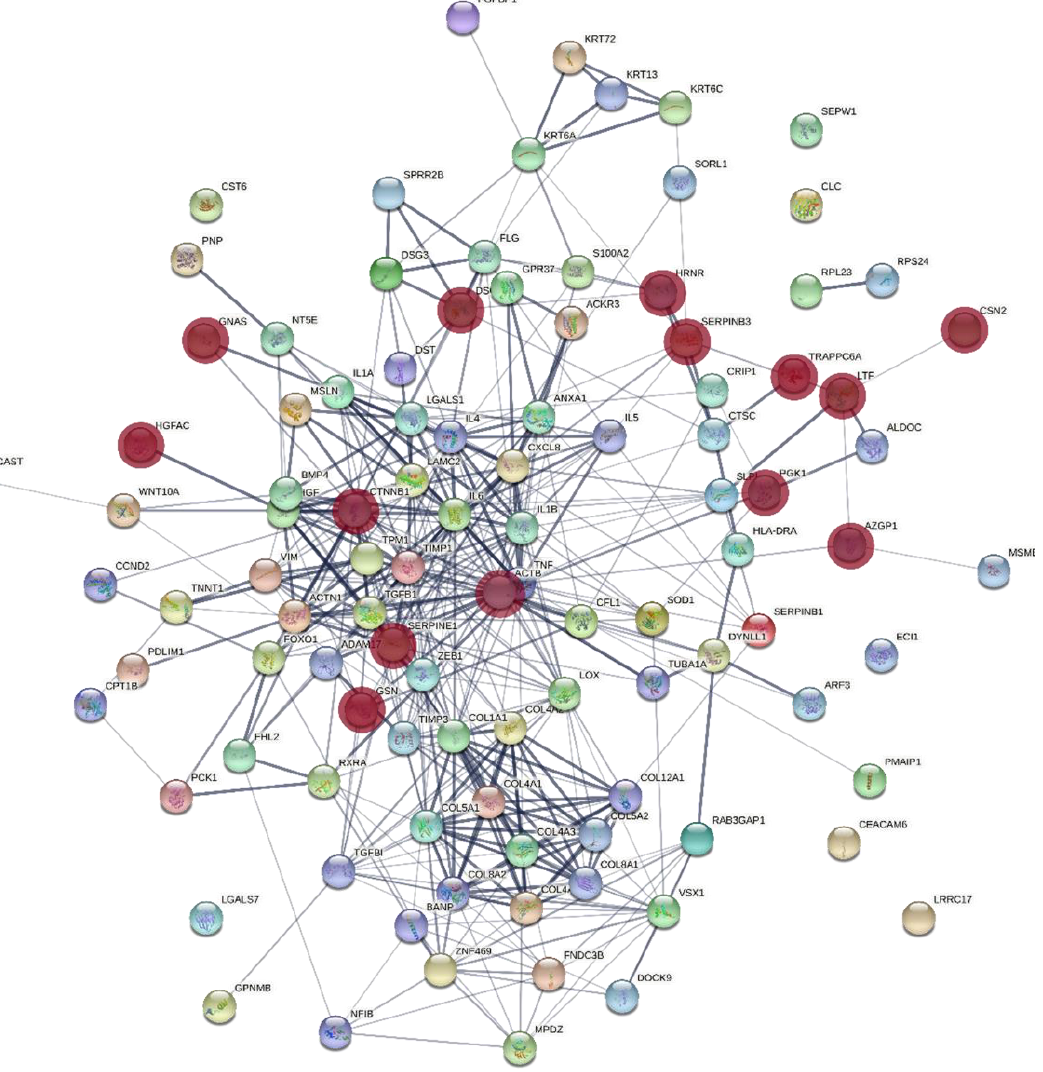
Figure 4. Functional association network of genes associated with central corneal thickness and KC. The STRING program was used to model the functional association of proteins whose expression is altered in exosomes of corneal stromal cells of patients with KC identified in this study (red nodes) with other genes related to the pathology in other studies cited in the bibliography.